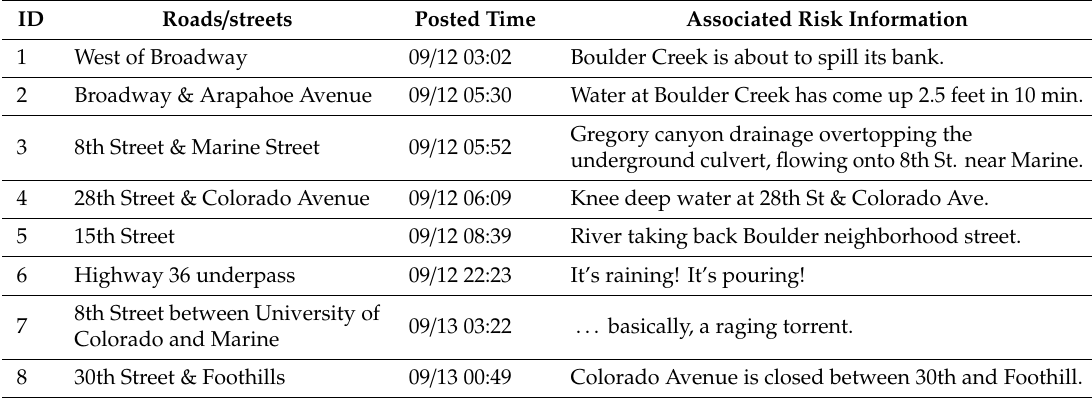
Table 1. Example of Identified Roads /